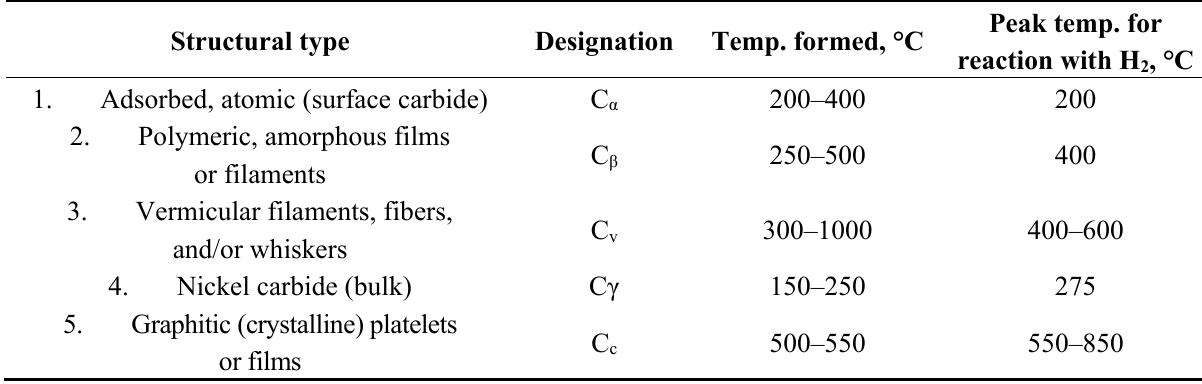
Figure 12. Formation and transformation of coke on metal surfaces (a, g, s refer to adsorbed, gaseous, and solid states respectively); gas phase reactions are not considered. Reproduced from [60]. Copyright 1983, Elsevier. Table 6. Forms and Reactivities of Carbon Species Formed by Decomposition of CO on Nickel a